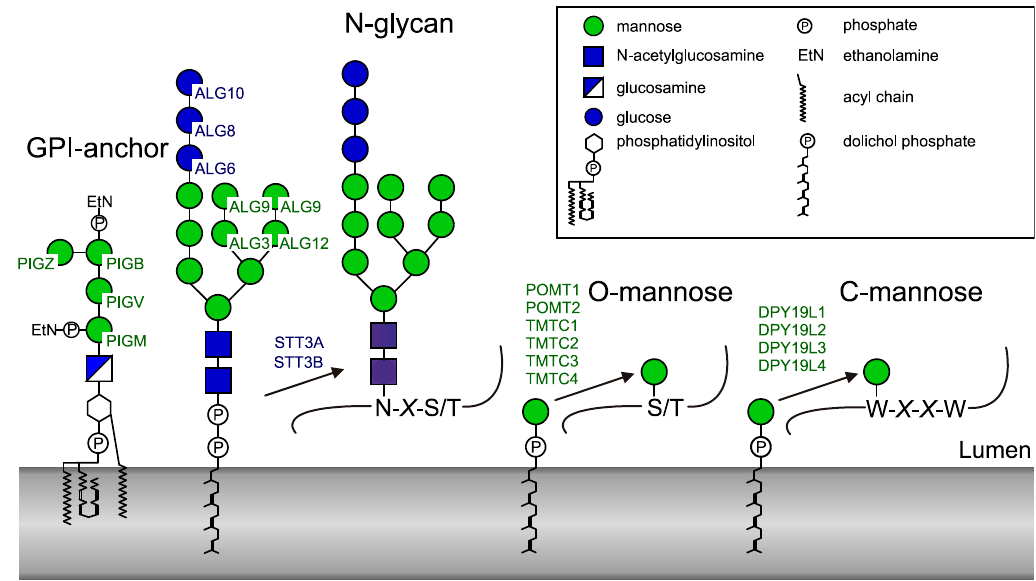
Figure 1. Human enzymes using dolichol-linked donor substrates. The official protein symbols (www.genames.org) of all known human enzymes are indicated. PIG (phosphatidylinositol glycan anchor) enzymes generate the GPI (glycosylphosphatidylinositol)anchor. ALG (asparagine-linked glycosylation) enzymes transfer four mannoses and three glucoses to the lipid-linked oligosaccharide before it is transferred to proteins by the oligosaccharyltransferase complex. STT3 (staurosporine- and temperature-sensitive) is the catalytic subunit of the oligosaccharyltransferase and occurs in two forms. Two POMTs (protein O -mannosyltransferases) and four TMTC (transmembrane and tetratricopeptide repeat containing) proteins transfer O -mannose to protein. Finally, four homologues of the Caenorhaditis elegans C -mannosyltransferase DPY-19 are present in human.